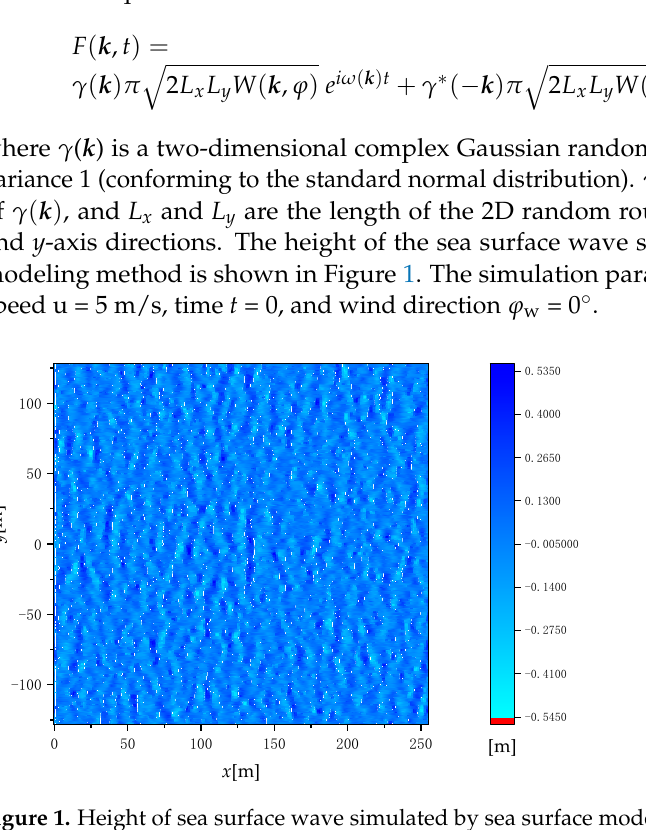
Figure 1. Height of sea surface wave simulated by sea surface modeling method.